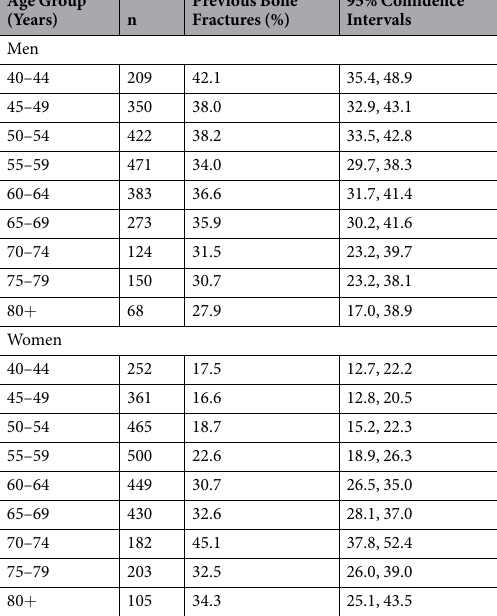
Table 1. Frequency (%) of previous bone fractures in the Ural Eye and Medical Study, stratified by sex and